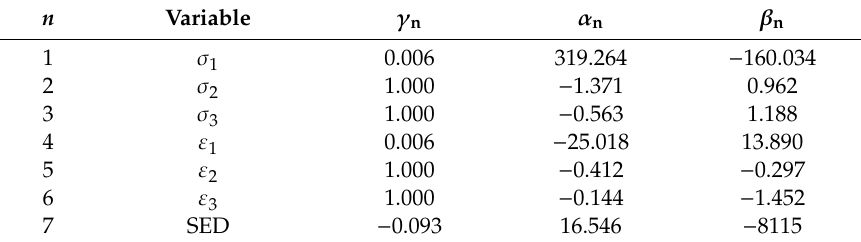
Table 4. Model weights of FDMP model for SBR tests. Initial data from